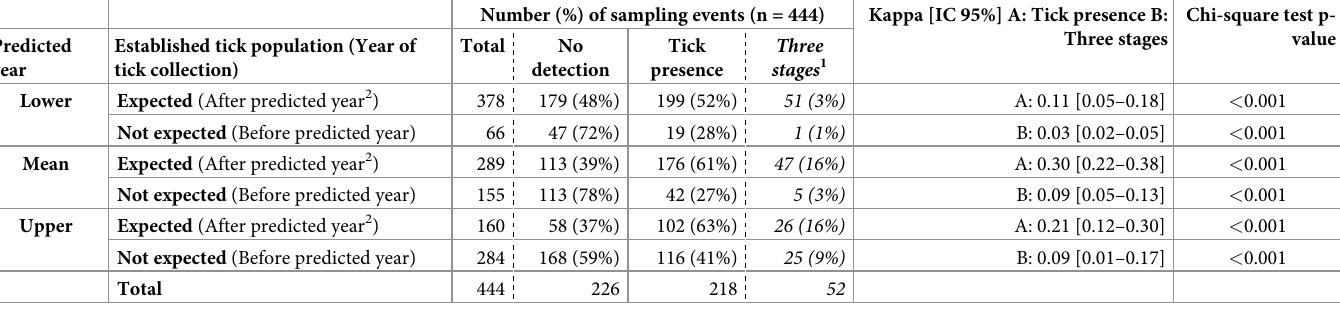
Table 1. Concordance between tick surveillance data and predicted year of establishment. Observed presence or absence of ticks during active surveillance (no detec- tion, tick presence, three stages) relative to model predictions (before or after the lower, mean and upper predicted year of establishment). Number (%) of sampling events (n =